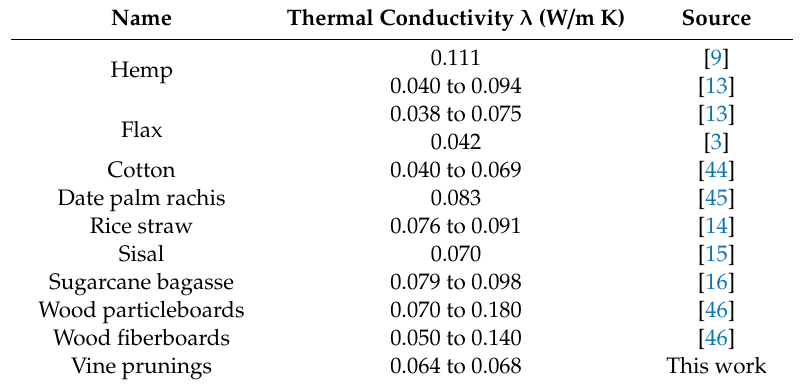
Table 5. Thermal conductivity coe ffi cients obtained in tests with di ff erent organic